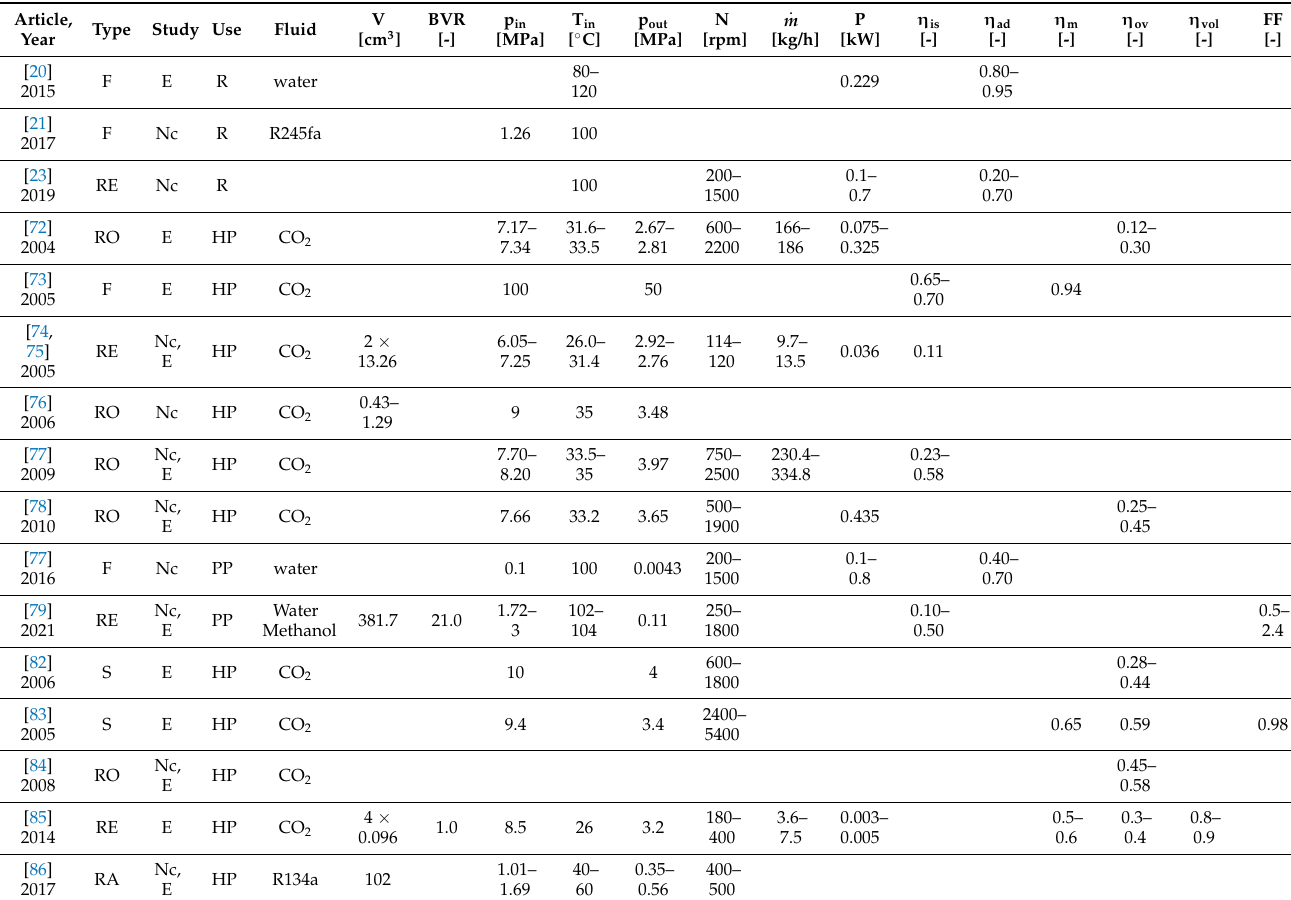
Table 4. Experimental and numerical results related to two-phase piston